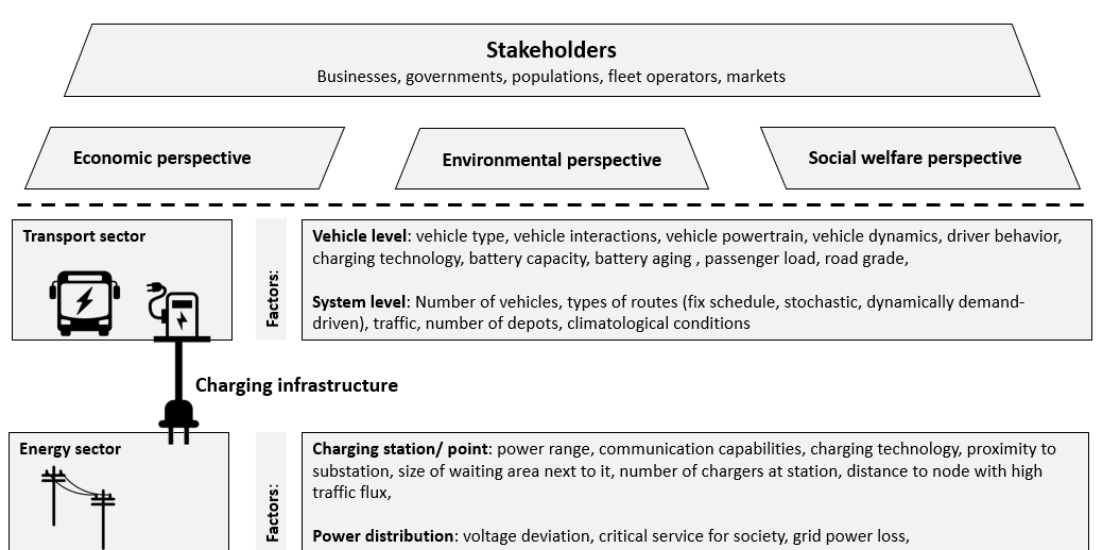
Figure 1. Overview of key micro- and macroscopic impact factors of the energy and transportation sector for planning charging infrastructure.